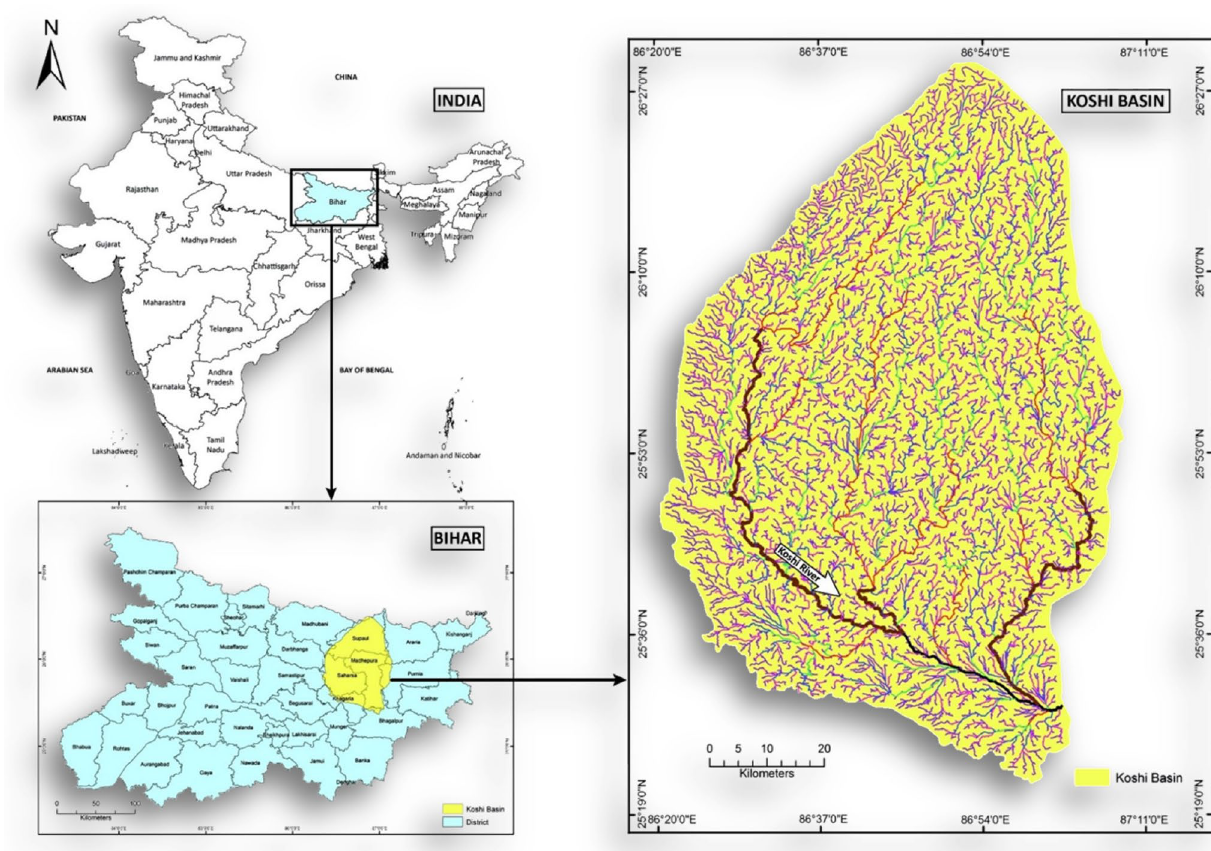
Fig. 1 Location map of lower Kosi basin in Bihar